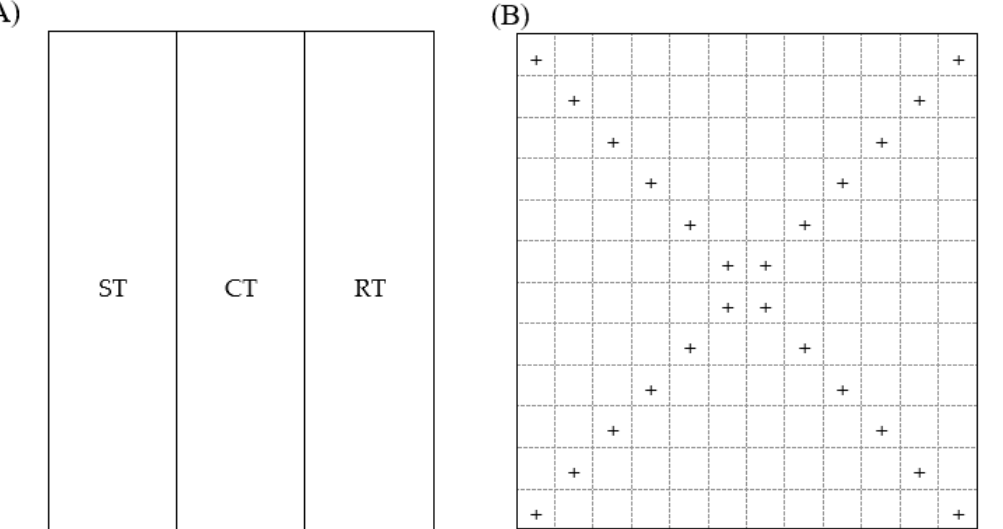
Figure 1. Treatment arrangement for the field experiment block. ( A ) One of four replications and the pattern of soil sampling from the plot and ( B ) ( + ) site for soil collection using Egner’s sampler. CT, conventional tillage; ST, strip-till; and RT, reduced